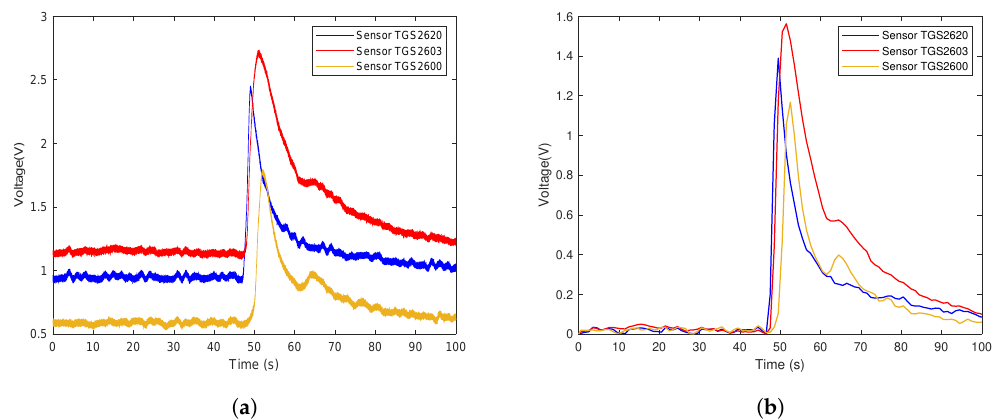
Figure 12. Time series of smoking gases raw data and the data after preprocessing in the second experiment. ( a ) Shows the representative example of the time series of the original response curves of the sensor array for gases from burning cigarettes. ( b ) Shows the results after